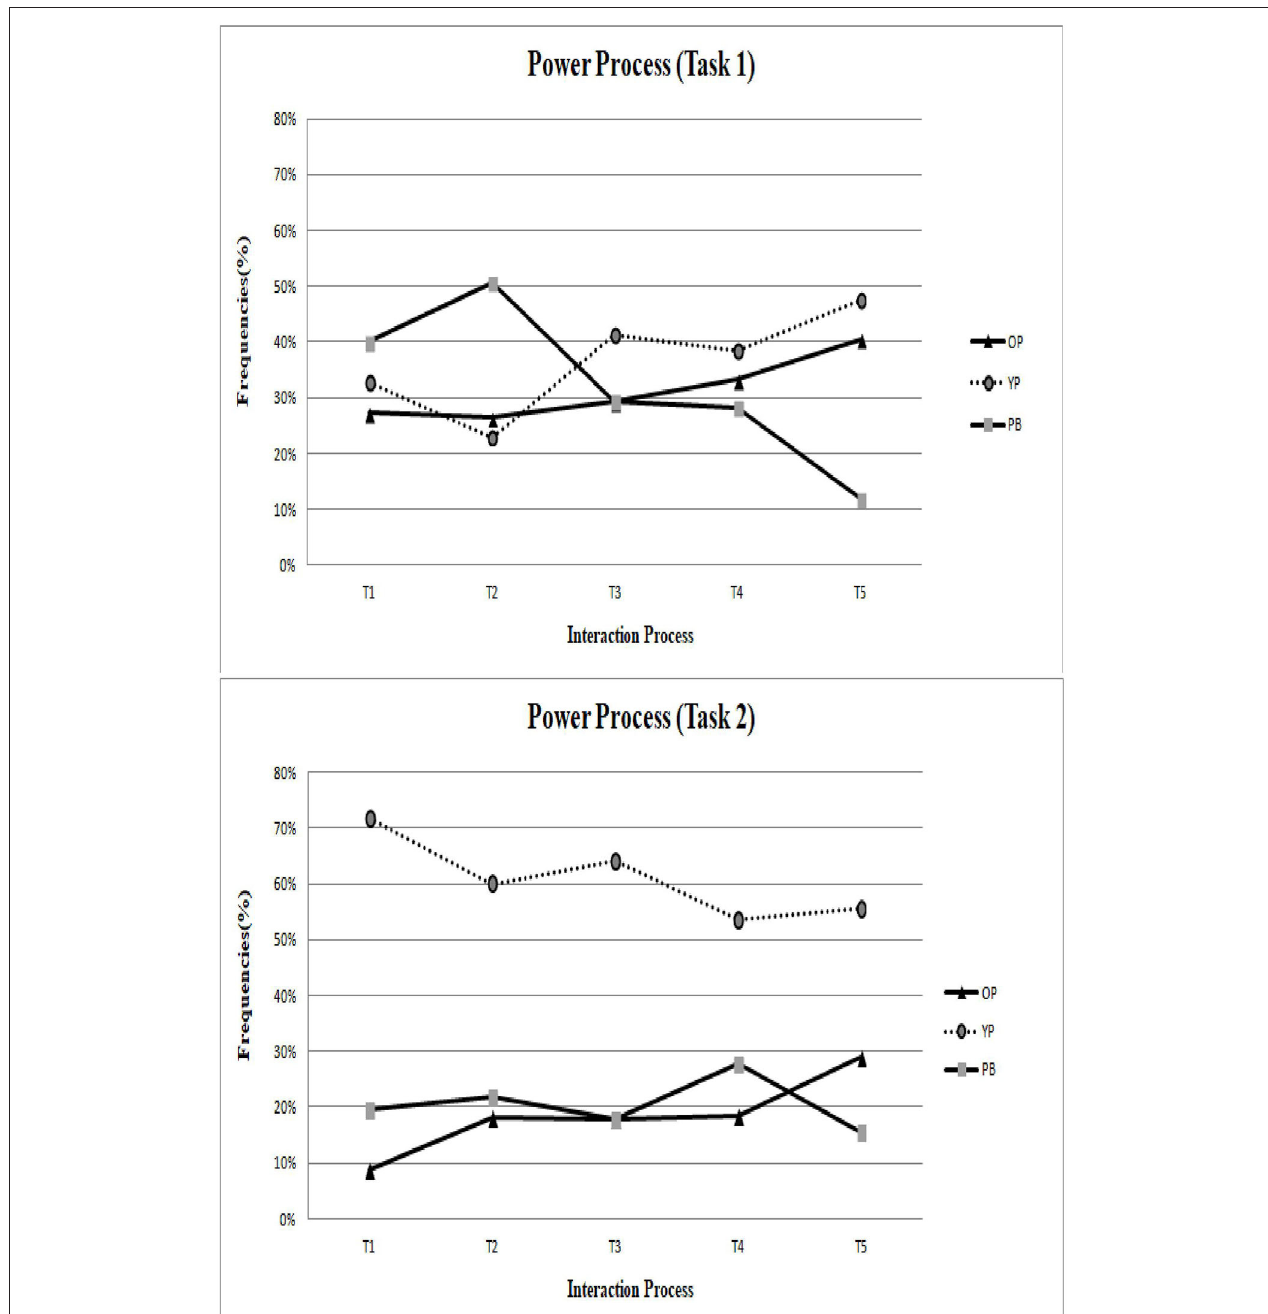
FIGURE 1 | The patterns of power process in Task 1 and Task